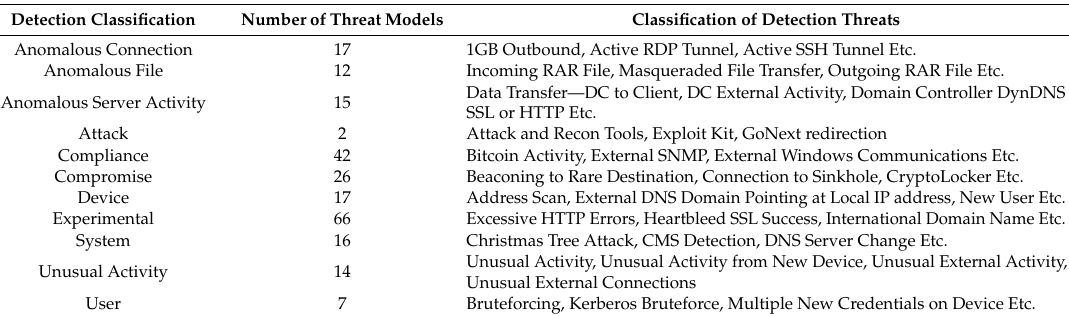
Figure 4. DarkTrace enterprise immune system operation process. Table 2. Darktrace’s built threat model.